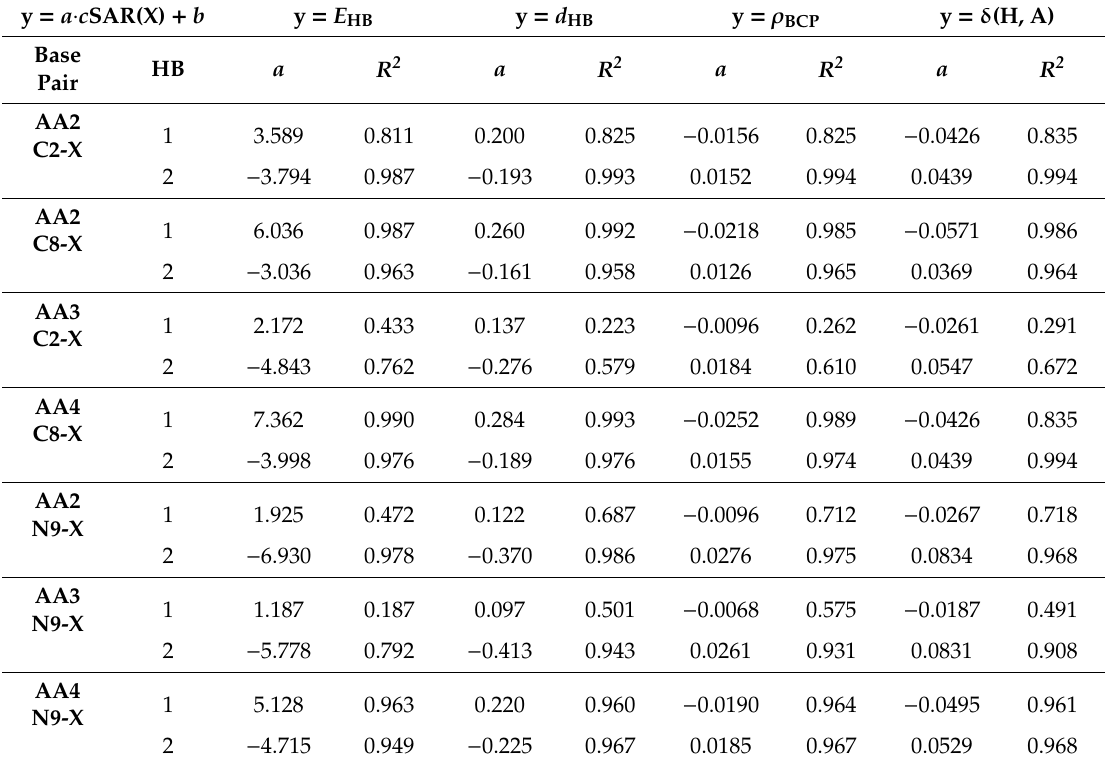
Table 3. Slopes of the obtained linear relations between the H-bond descriptors (y) and c SAR(X), and the determination coe ffi cients ( R 2 ) for the substituted adenine